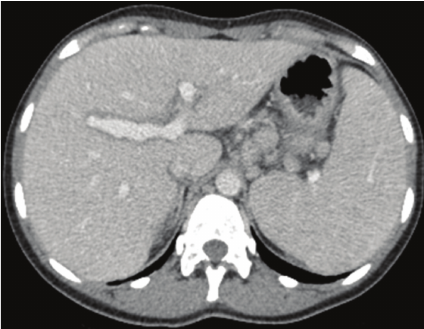
Figure 1: Abdominal CT showing mild liver and spleen enlarge- ment.